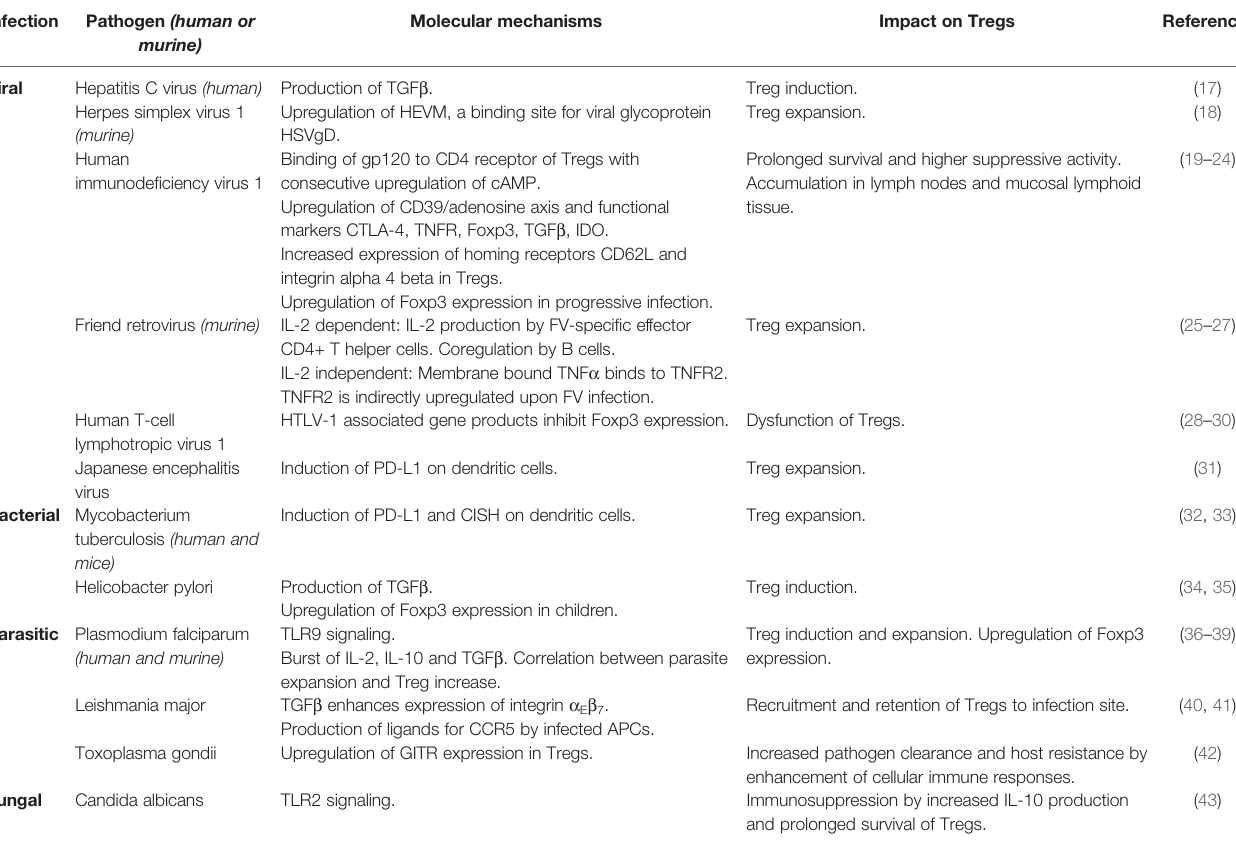
TABLE 1 | Impact of pathogens on Tregs and the underlying molecular